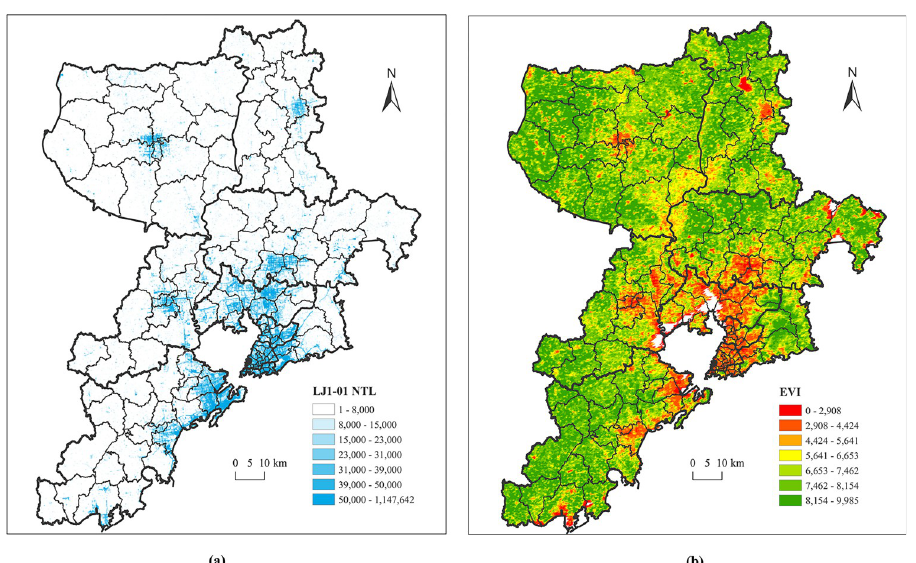
Fig 3. (A) The Luojia 1–01 NTL imagery of Qingdao in 2018; (b) The EVI imagery of Qingdao in 2018. We used the bilinear interpolation algorithm to unify the spatial resolution of Luojia 1–01 NTL data (Fig 3A) and EVI data (Fig 3B) to 100m, and calculated HSI values for Qingdao City in 2018 by using (3)